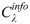
A brain region’s propensity to be a costly source or target.Cortical surfaces show the difference between a node’s source and target transmission costs. (a) C→λtrans−C←λtrans for routing strategies generated with the values λ1, λ2, λ3 and λ4. (b) C→λinfo−C←λinfo for routing strategies generated with the values λ1, λ2, λ3 and λ4. Red colored areas on the cortical surfaces correspond to nodes whose source transmission/informational cost is higher than their target transmission/informational cost. Blue colored areas correspond to nodes whose target transmission/informational cost is higher than their source transmission/informational cost. In all panels, λ1 = e-4.49, λ2 = e-1.64, λ3 = e0.37 and λ4 = e1.79.